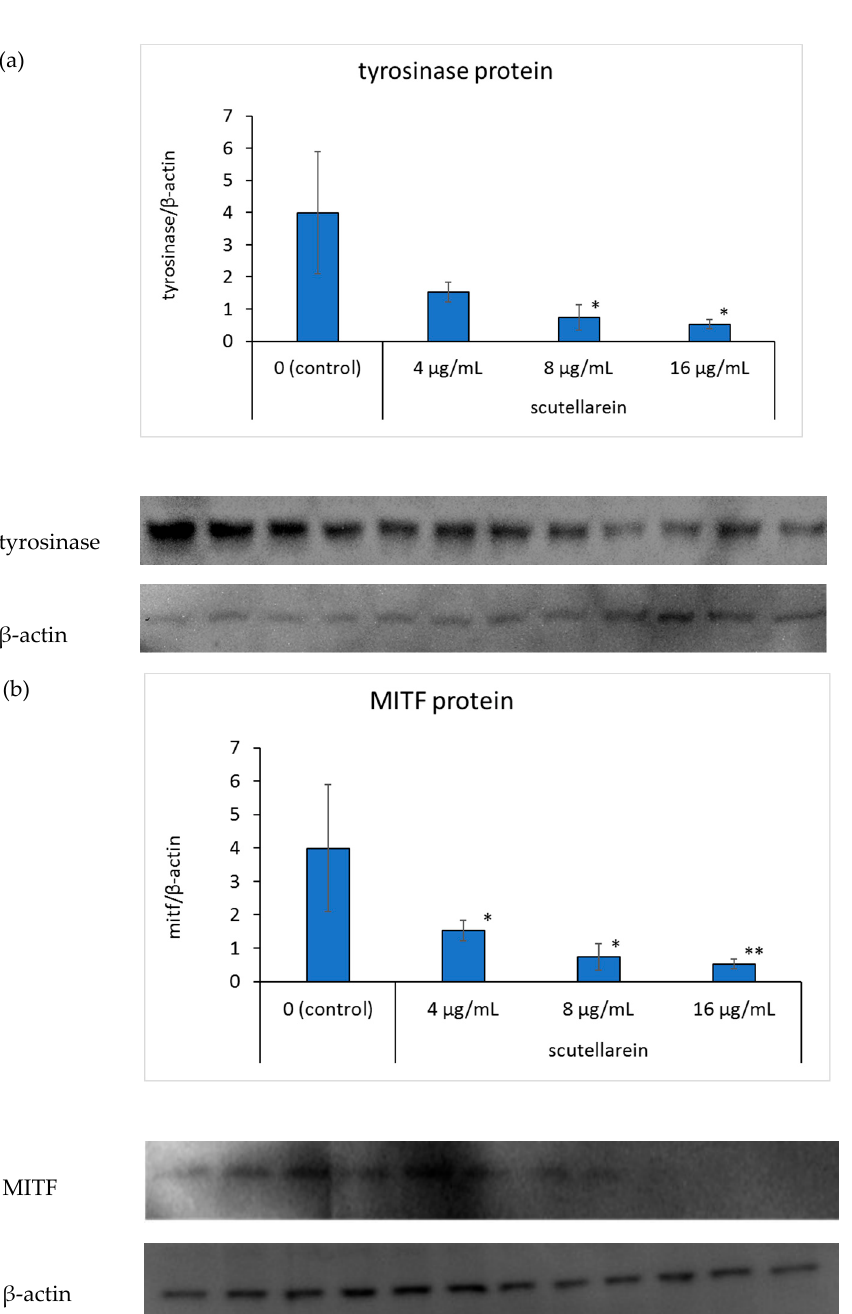
Figure 6. The effects of scutellarein on tyrosinase protein ( a ) and microphthalmia-associated tran- scription factor (MITF) protein ( b ) expressions. B16 cells were treated with different concentrations of scutellarein for 48 h. Western blot analysis was then conducted using an anti-tyrosinase antibody or anti-MITF antibody; β -actin was used as a loading control. Fluorescence intensities of tyrosinase and β -actin were quantified using ImageJ. Band intensities were normalized to β -actin. Data are presented as the mean ± SD of experiments performed in triplicate. ∗ p < 0.05 compared to the control. ∗∗ p < 0.01 compared to the control.